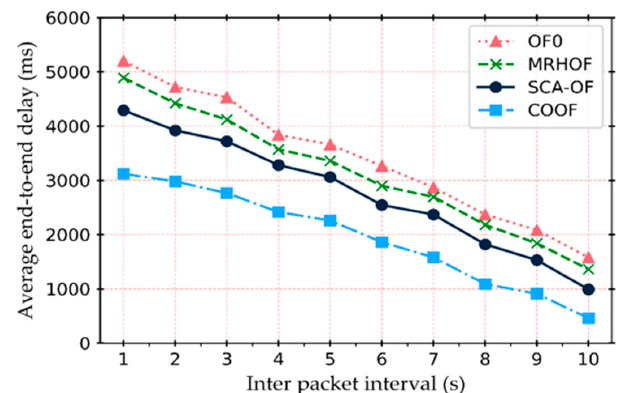
Figure 12. Average end-to-end delay with respect to different inter packet interval.